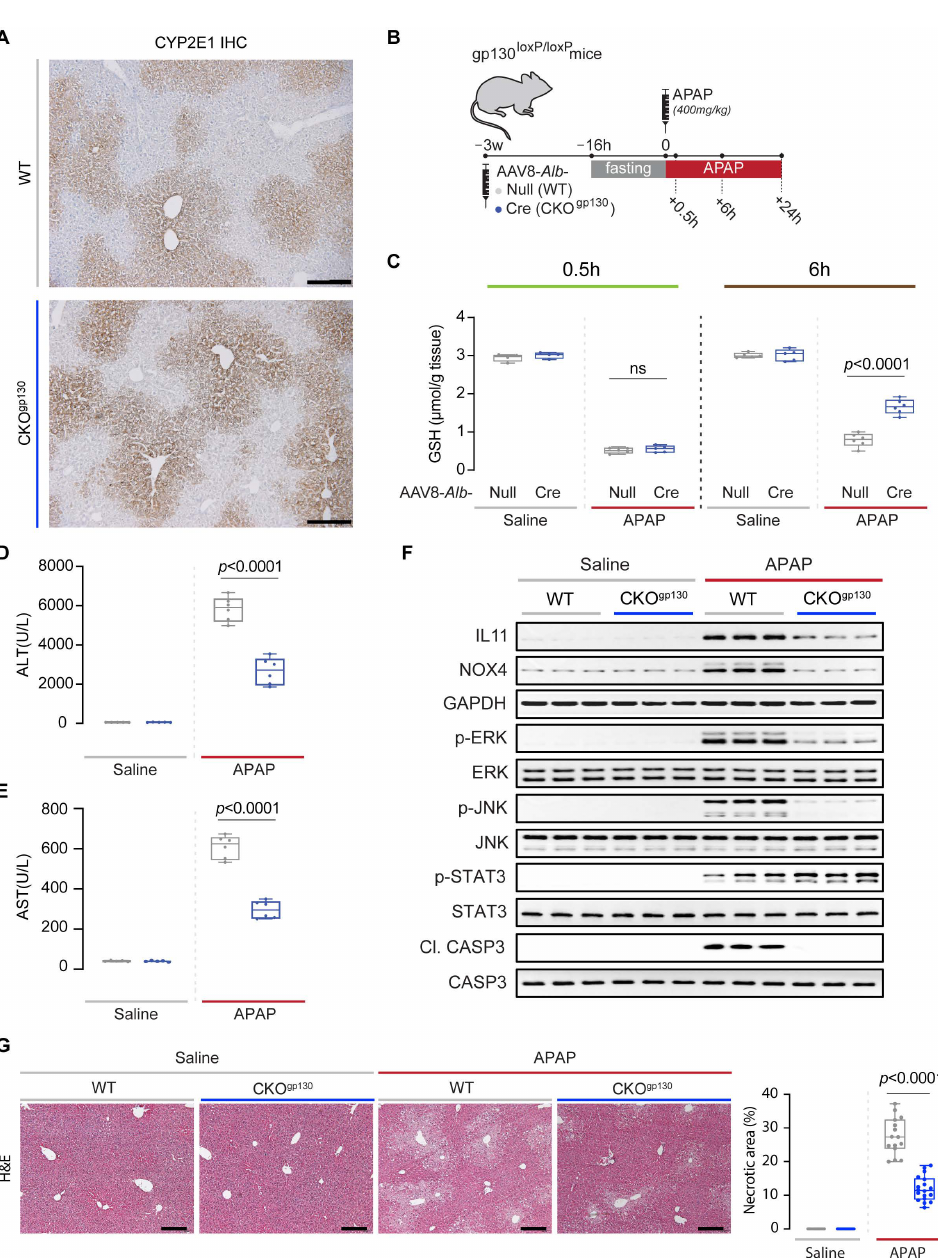
Figure 2. Hepatic CYP2E1 and glutathione levels and serum and molecular markers of liver injury in mice with hepatocyte-specific gp130 deletion and control mice. ( A ) Representative immunohisto- chemistry images (scale bars, 200 µ m; representative dataset from n = 3 mice/group). ( B ) Schematic of APAP induction in wild-type (WT) and CKO gp130 mice: overnight-fasted mice were injected with saline or APAP (400 mg kg − 1 ); livers and serum were collected either 0.5, 6, or 24 h post-APAP dosing for experiments shown in ( C – F ) and Figure 3. ( C ) Hepatic GSH concentrations at 0.5 and 6 h post-APAP. ( D ) ALT, ( E ) AST, and ( F ) Western blots of IL11, NOX4, GAPDH, p-ERK, ERK, p-JNK, JNK, p-STAT3, STAT3, Cl. CASP3, and CASP3 ( n = 3/group) at 6 h post-APAP. ( G ) Representa- tive H&E-stained liver images (scale bars, 200 µ m) at 6 h post-APAP dosing and quantification of liver necrotic area. ( C – E , G ) Data are shown in a box-and-whisker plot with median (middle line), 25th–75th percentiles (box) and min-max values (whiskers), with a 2-way ANOVA with Sidak’s correction; 0.5 h time point: saline ( n = 4 mice/genotype), APAP ( n = 4 mice/genotype), 6: saline ( n = 5 mice/genotype), APAP ( n = 6